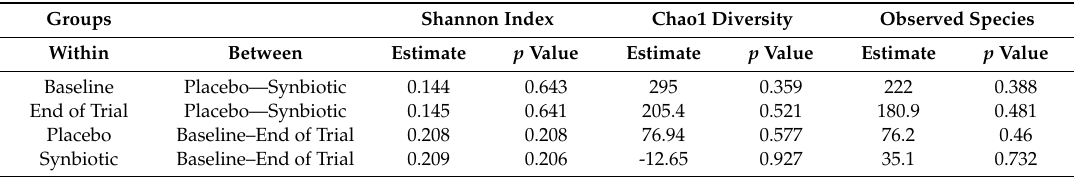
Table 2. Measuring statistical di ff erences in alpha diversity between groups. Three alpha diversity metrics were used (Shannon Index, Chao1 Estimator, and Observed Species / OTUs). Significant di ff erences between groups were determined using the estimated marginal means analysis applied to linear mixed model, which was built with alpha diversity as the response variable, the treatment group and time points as predictor variables, and subject number as a random variable.